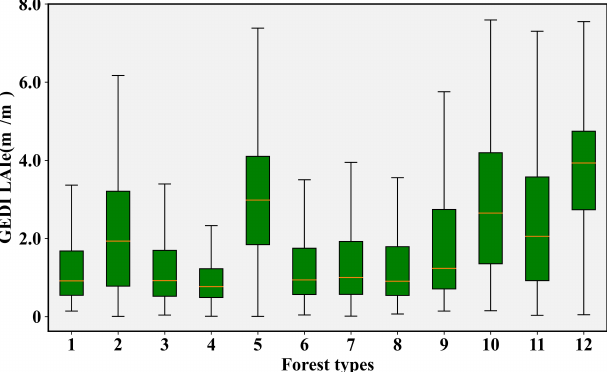
Figure 6. Values of GEDI LAIe among forest types. The values from 1 to 12 on the X -axis